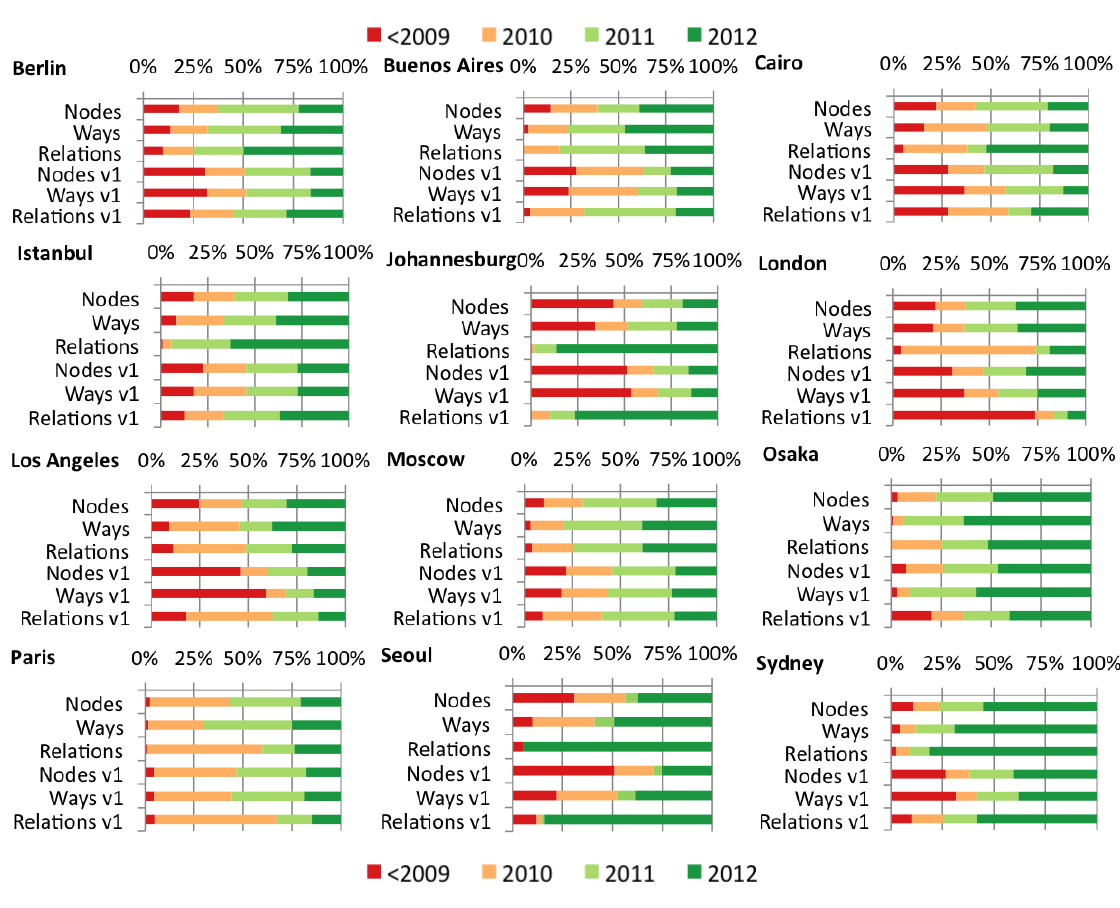
Figure 6. Distribution of currency and data versions per urban area (Oct.